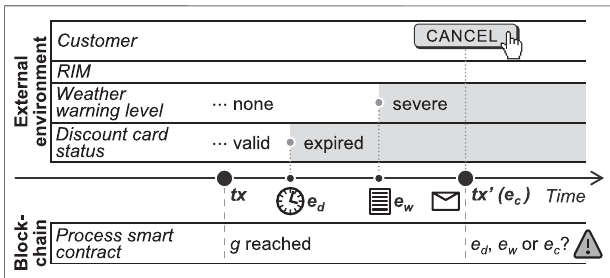
Frontiers in Blockchain |